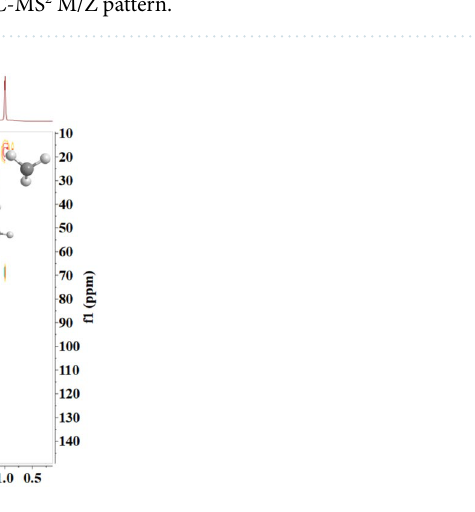
Figure 5. 1 H spectra and 13 C HSQC NMR spectra of the new Compound